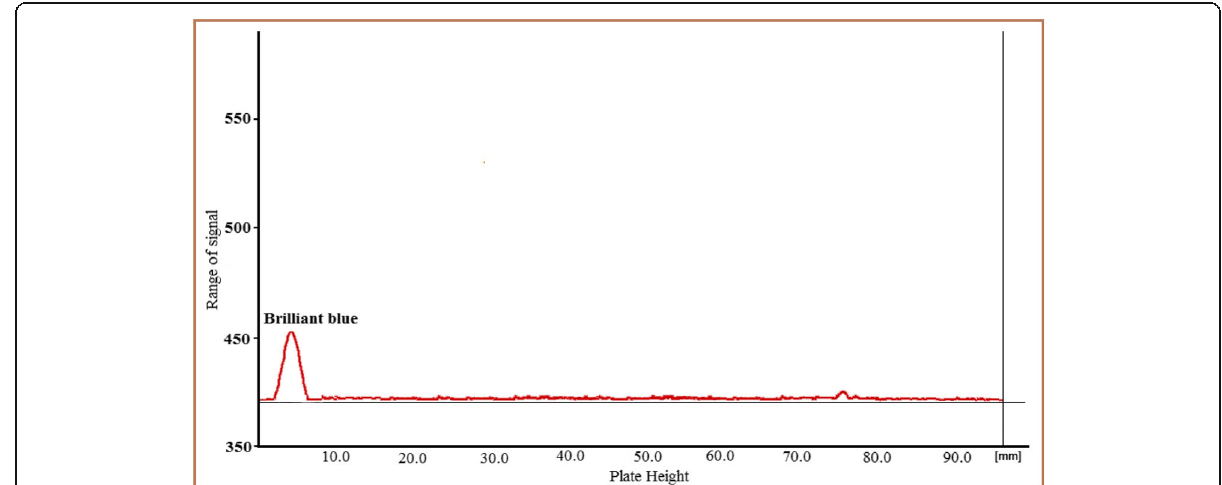
Fig. 11 Densitographic illustration of identification of brilliant blue in Ambrodil*S syrup with preliminary separation from associated components on S 2 with M